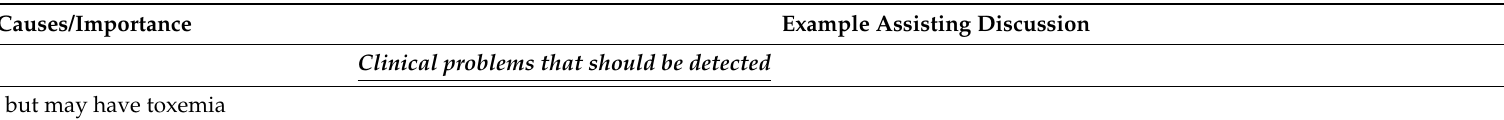
Table 2. Using an example of undifferentiated calf diarrhea in assisting veterinary learners with problem recognition and the specific roles of each problem in the entire problem presentation during a case-based discussion or a clinical